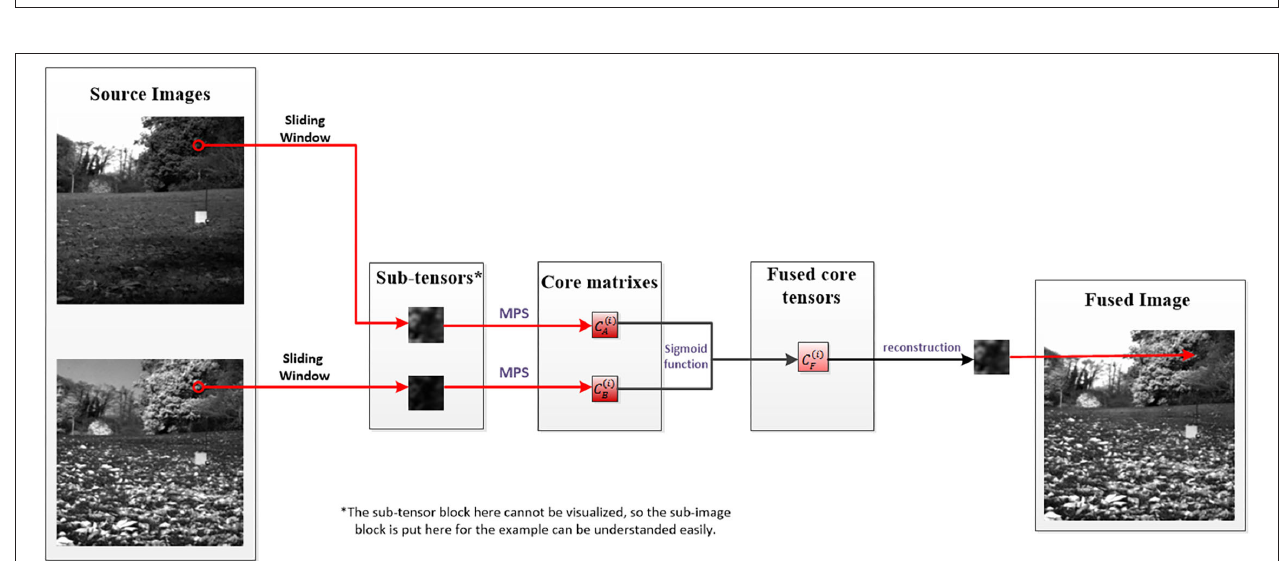
FIGURE 2 | The graphical representation of the sliding window technology.